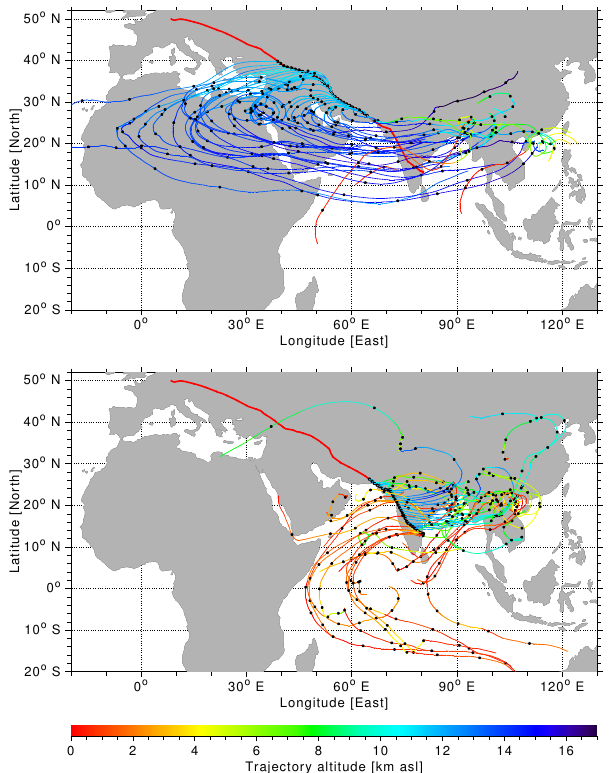
Figure 10. Ten-day backward trajectories for CARIBIC flight 244 to Chennai on 13 August 2008. Upper panel: trajectories north of the wind reversal at 26.6 ◦ N. Lower panel: trajectories south of the wind reversal. Every second trajectory is plotted for clarity. The colour indicates the trajectory altitude (in km above sea level) and the black dots mark 24h time steps along the trajectories. The CARIBIC flight track is shown by the thick red